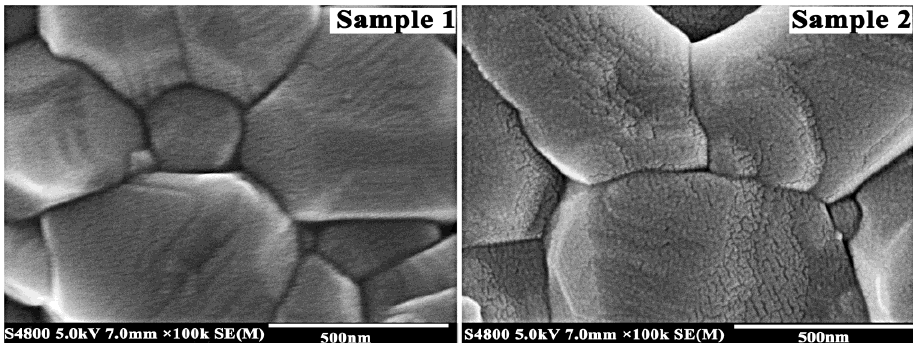
Figure 5. FESEM photographs of microstructure between grains of Samples 1 and 2.